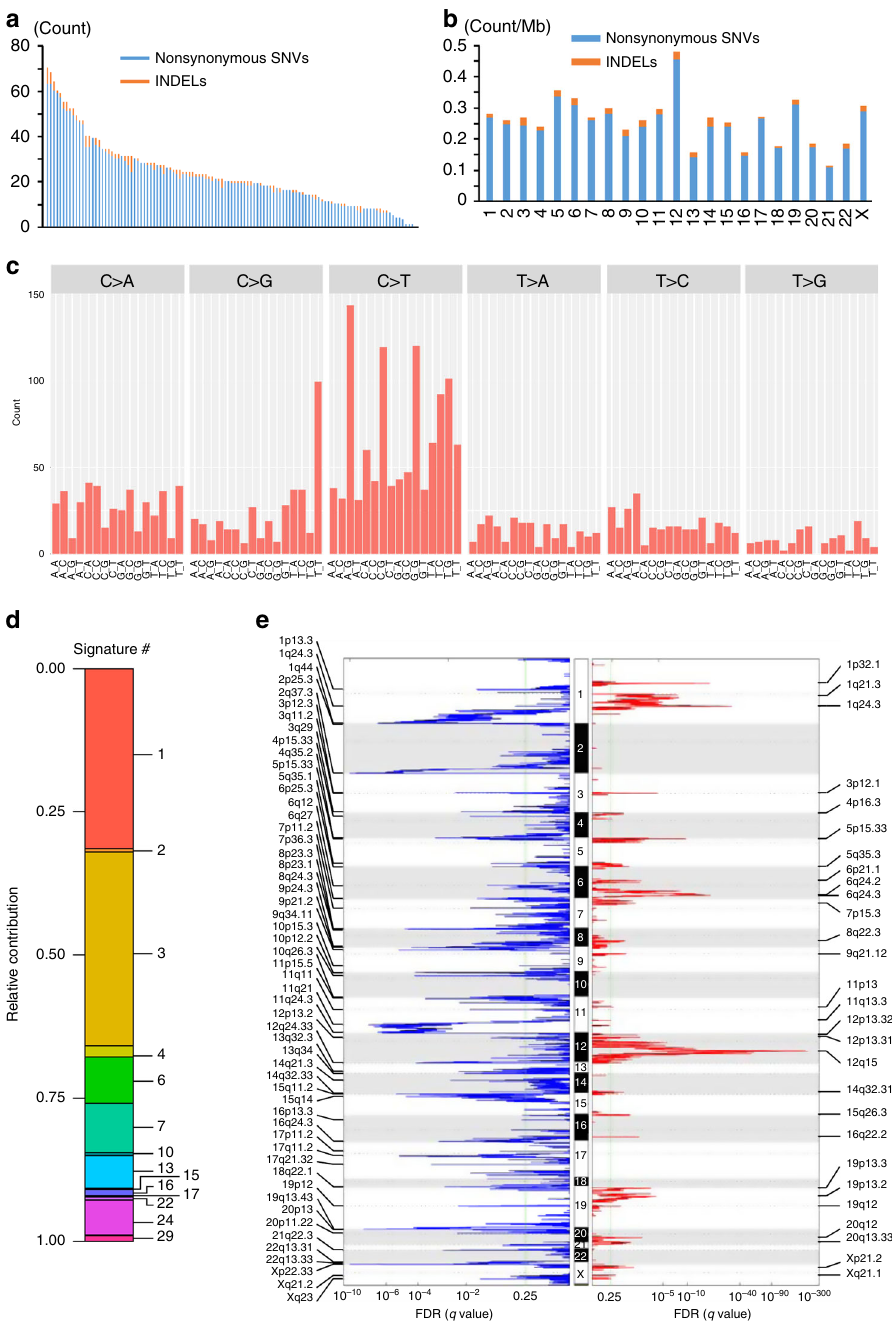
Fig. 1 Characteristics of the somatic mutations and copy-number alterations in DDLPS. a Frequency of nonsynonymous SNVs and short INDELs identi fi ed by exome sequencing for each DDLPS sample. b Mean mutation frequency per megabase of coding sequence for each autosomal chromosome. Light blue and orange bars represent the frequency of SNVs and short INDELs, respectively. c 96 substitution classi fi cation for DDLPS samples. SNVs were classi fi ed according to six base substitution patterns, C > A, C > G, C > T, T > A, T > C, and T > G, and also based on the identity of the bases immediately 5 ′ and 3 ′ to each mutated base. d Mutation signature analysis for 119 DDLPS samples. The values represent the contribution of each signature (left) and the signature number (right). e Chromosomal regions with gained (red) and lost (blue) SCNAs identi fi ed in 119 DDLPS samples using GISTIC 2.0. The genes in each region are listed in Supplementary Data 1 and